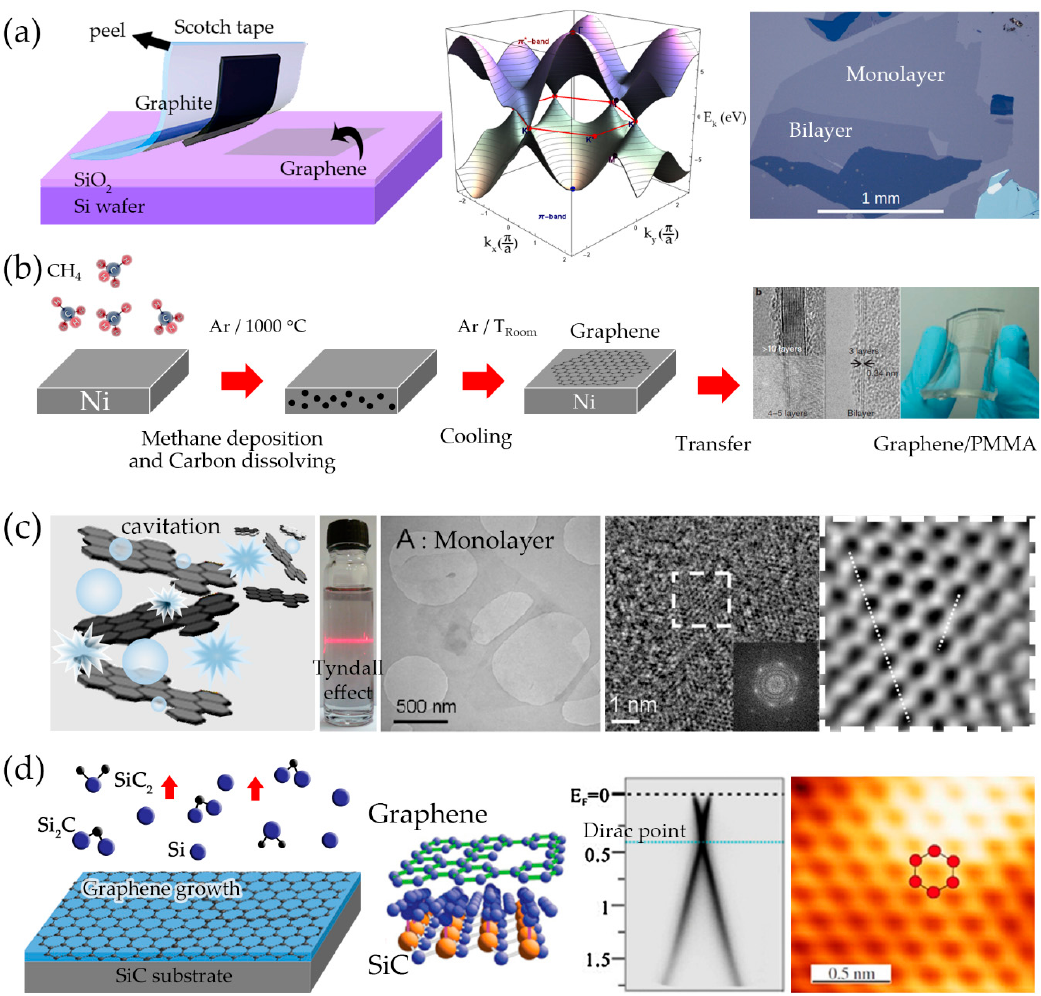
Figure 3. Several techniques of graphene synthesis: ( a ) graphene sheet is left on top of a silicon oxide wafer exfoliated by scotch-tape technique, its electronic band structure, and the real monolayer and bilayer graphene (Reprinted with permission from [39]); ( b ) Large scale process of graphene growth using (chemical vapor deposition) CVD and the transferred graphene to poly(methyl methacrylate) (PMMA) (reprinted with permission from [40]); ( c ) Liquid exfoliation of graphene showing crystalline honeycomb pattern on the exfoliated layer (reprinted with permission from [41]); and ( d ) epitaxial graphene growth on a silicon carbide (SiC) by sublimation of Si atoms and the structural characteristic of the monolayer graphene (reprinted with permission from [42]).